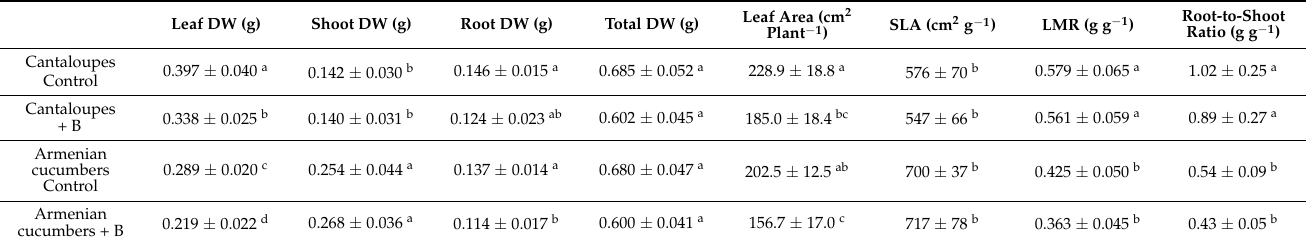
Table 1. Effect of the oversupply of B (by using H 3 BO 3 ) on growth and morphology of cantaloupes ( C. melo var. Cantalu- pensis cv. Retato Degli Ortolani) and Armenian cucumbers ( C. melo var. flexuosus cv. Abruzzese Tortarello). Growth period lasted 35 d, where no visible B toxicity symptoms were apparent (Figure 1). Means followed by different letters indicate significant differences ( p = 0.05; per cultivar comparison in columns). Values are the mean of ten replications ( ± SD). DW, dry weight; SLA, specific leaf area; LMR, leaf mass